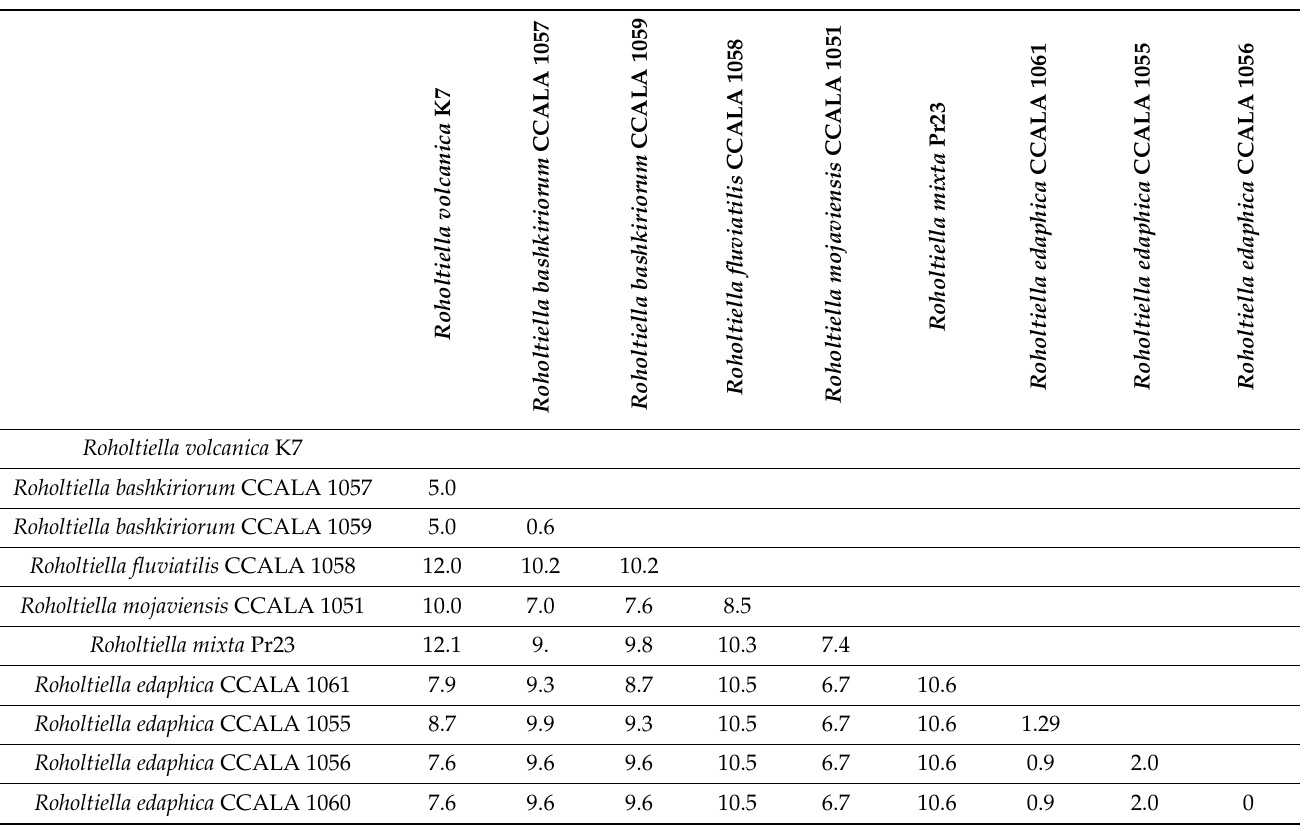
Table 2. Percent dissimilarity of the 16S–23S ITS region based on orthologous operons found among strains of Roholtiella .